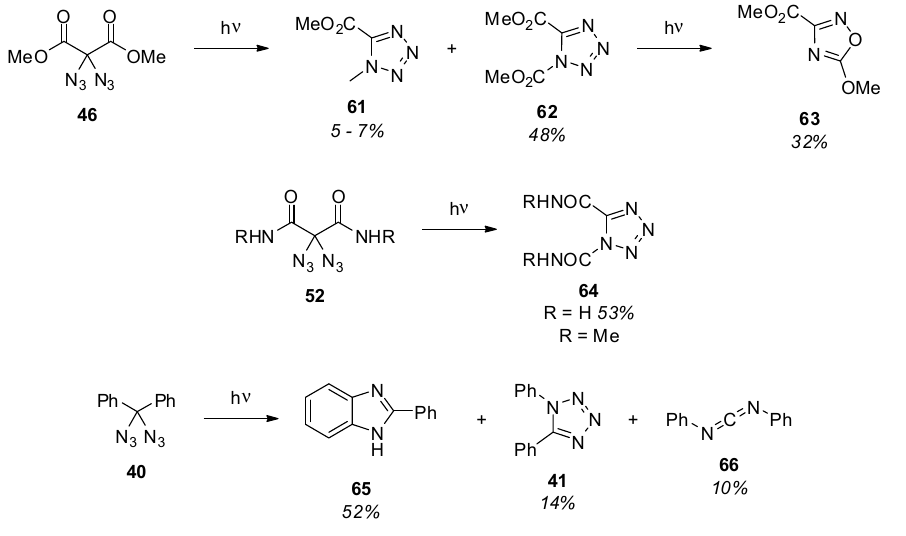
Scheme 12. Photochemical decomposition of methyl 2,2-diazidomalonate ( 46 ), 2,2-diazidomalonamides 52 and diazidodiphenylmethane ( 40 ).